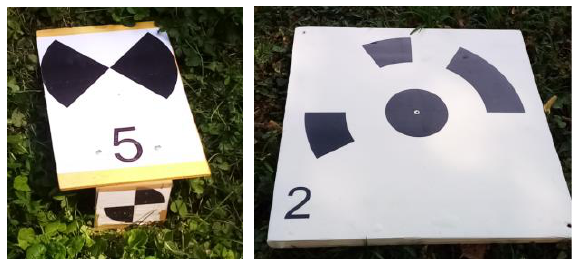
Figure 2. left – smaller targets and right larger targets used for the The ground survey consisted in using a GNSS receiver in RTK mode. The points resulted having an average accuracy (RMSE) of 2.20 cm and 2.73 cm horizontally and vertically